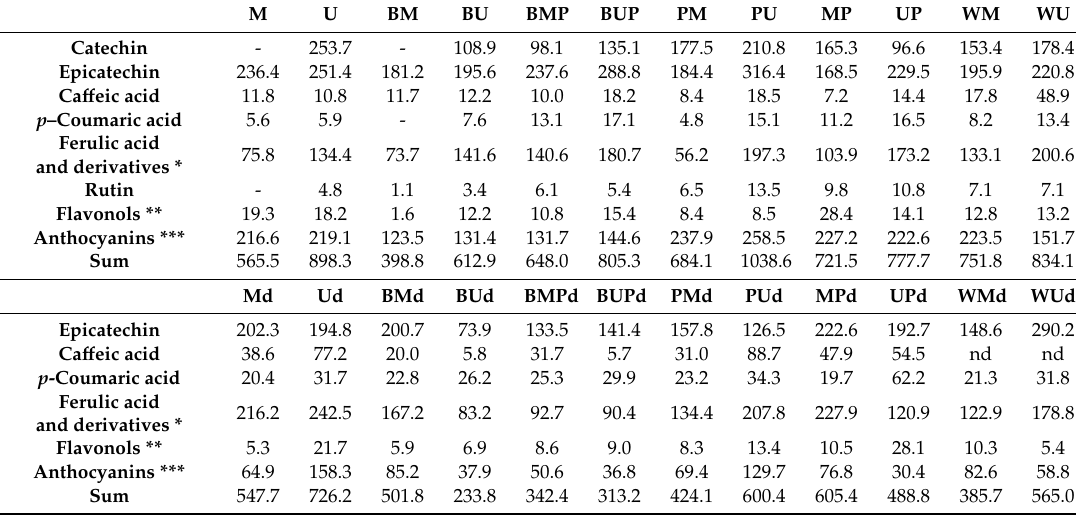
Table 3. HPLC-DAD quantitative